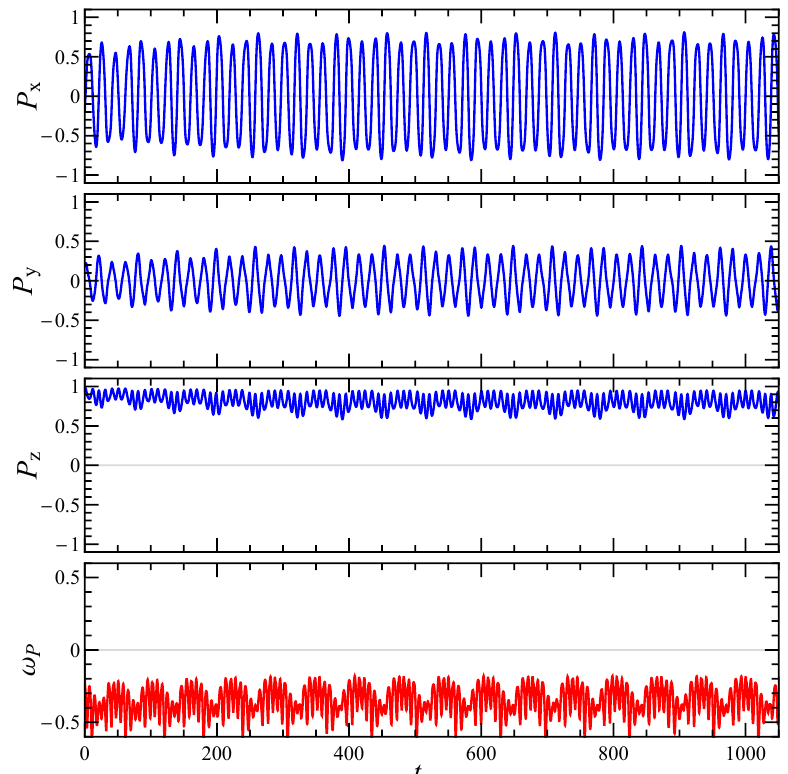
Figure 4. Time evolution of the components of the particle smallest principal axis of inertia P and of the angular velocity around it ω P , for an initial orientation close to the vorticity axis z . The aggregate